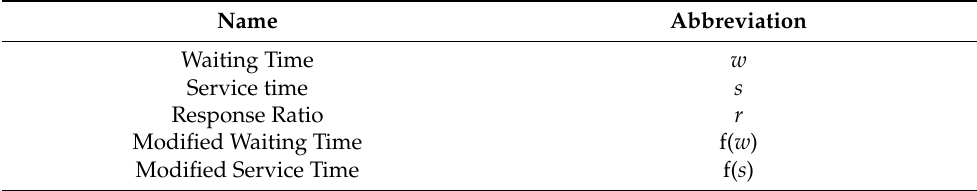
Table 1. Symbol table of the algorithm.